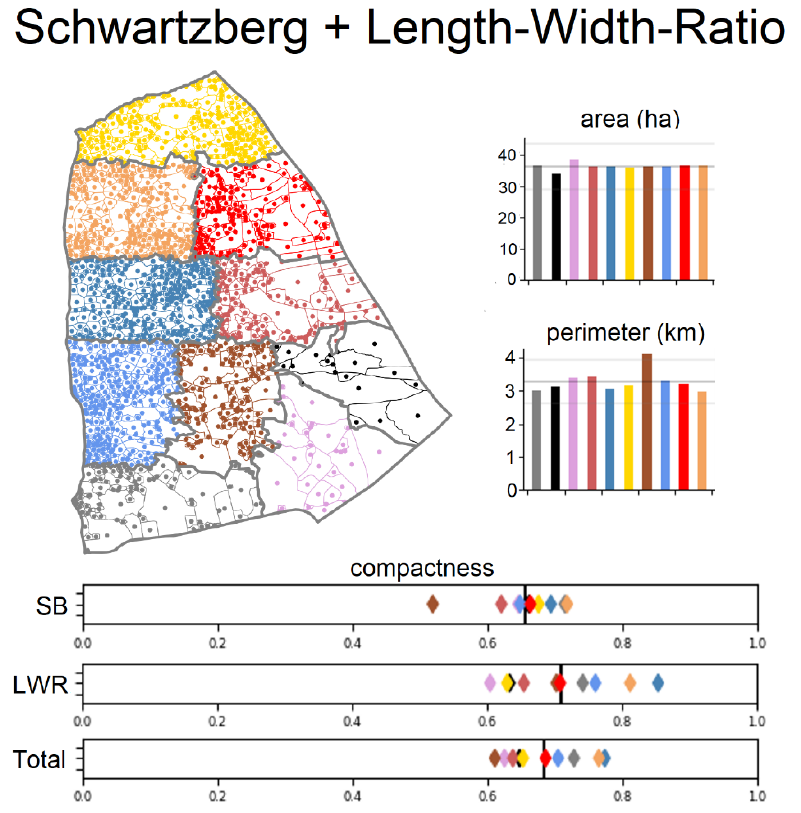
Figure 6. Area classification by weighted compactness measures.